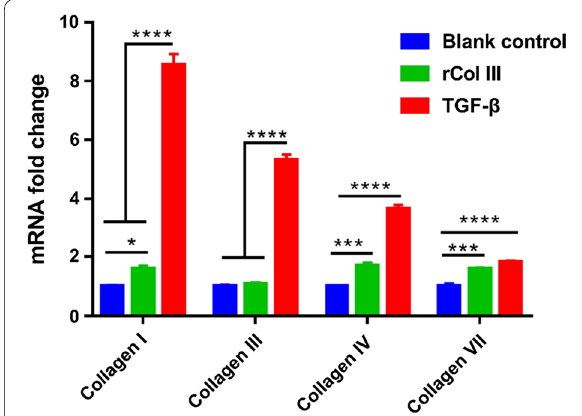
Fig. 7 Effect of rhCol III and TGF-β on ECM expression of HSF at the gene level (collagen I, collagen III, collagen IV and collagen